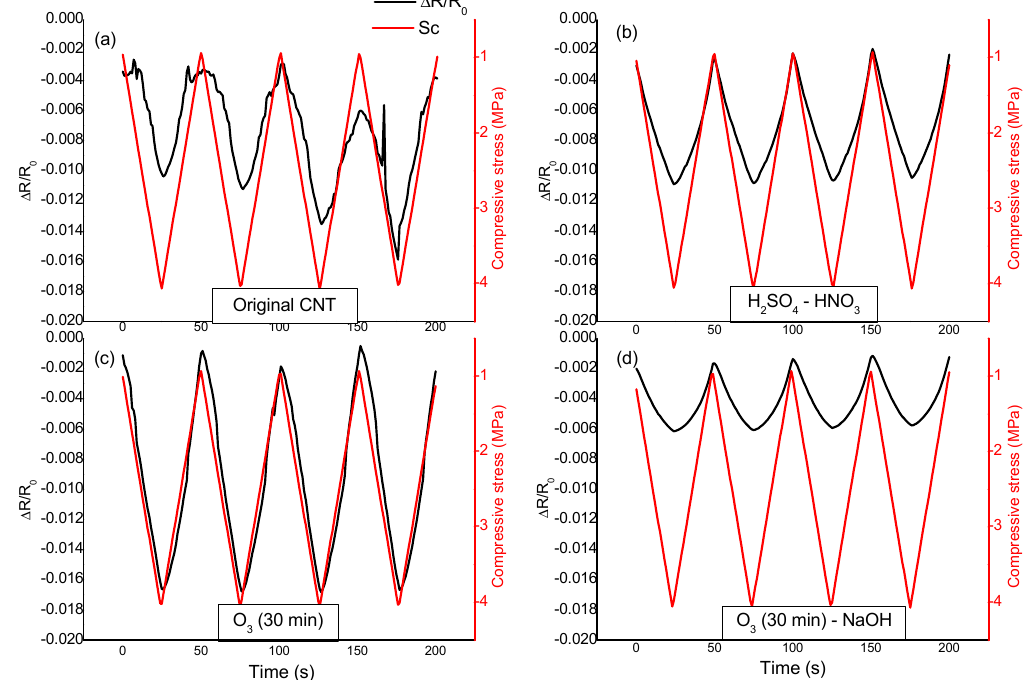
Figure 6. Self-sensing tests for 1.0% of CNT cement paste subjected to different functionalization treatments: ( a ) original CNTs; ( b ) CNTs-(HNO 3 -H 2 SO 4 ); ( c ) CNTs-O 3 -30 min; ( d ) CNTs-O 3 -30 min-NaOH. 180 day-old specimens, with a 1 mA DC current, 200 N/s load rate, initial load of 1.5 kN and a maximum load of 6.5 kN.